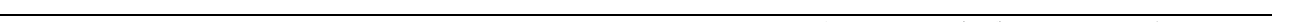
Fig. 4 Healthy visceral WAT expansion in obesity depends on mural Pparg expression. a Pdgfrb rtTA ; TRE-Cre; Pparg loxP/loxP (Mural- Pparg KO ) mice are generated by breeding the Pdgfrb rtTA transgenic mice to animals expressing Cre recombinase under the control of the tet-reponse element ( TRE-Cre ) and carrying fl oxed Pparg alleles ( Pparg loxP/loxP ). Littermates carrying only Pdgfrb rtTA and Pparg − loxP/loxP alleles (i.e. Cre − ) were used as the control animals. b Control and Mural- Pparg KO mice were fed a standard chow diet until 8 weeks of age before being switched to dox-containing HFD for another 20 weeks. Body weights were measured weekly. Control-HFD, n = 14; Mural- Pparg KO -HFD, n = 13. Data points represent mean + s.e.m. c Fat mass and lean mass (normalized to body weight) of control and Mural- Pparg KO mice after 20 weeks of dox-diet feeding. n = 7 per genotype. Bars represent mean + s.e.m. d Fat pad weight (normalized to body weight) of control and Mural- Ppar γ KO mice after 20 weeks of dox-HFD feeding. * denotes p < 0.05 from Student ’ s t -test. Control-HFD, n = 14; Mural- Pparg KO -HFD, n = 13. Bars represent mean + s.e.m. e – h Representative immuno fl uorescence staining of Perilipin (green) and Mac-2 (red) in e , f gonadal and g , h perirenal WAT paraf fi n sections obtained from control and Mural- Pparg KO mice after 20 weeks of dox-diet feeding. Scale bar, 200 μ m. i – l Representative trichrome staining of i, j gonadal and k, l perirenal WAT paraf fi n sections obtained from control and Mural- Pparg KO mice after 20 weeks of dox-diet feeding. Scale bar, 200 μ m. m Number of crown-like structures (Mac-2 positive) in the indicated depots obtained from control and Mural- Pparg KO mice after 20 weeks of dox-HFD feeding. * denotes p < 0.05 from Welch ’ s t -test. n = 24 randomly chosen ×10 magni fi cation fi elds from six individual animals. Bars represent mean + s.e.m. n Average adipocyte size in indicated fat depots from control and Mural- Pparg KO mice after 20 weeks of dox-HFD feeding. * denotes p < 0.05 from Student ’ s t -test. Control-HFD, n = 8; Mural- Pparg KO -HFD, n = 7. Bars represent mean + s.e.m. o , p Relative mRNA levels of indicted genes in o gonadal and p perirenal WAT obtained from control and Mural- Pparg KO mice after 20 weeks of dox-chow diet feeding. * denotes p < 0.05 from Welch ’ s t -test. n = 6 per genotype. Bars represent mean +